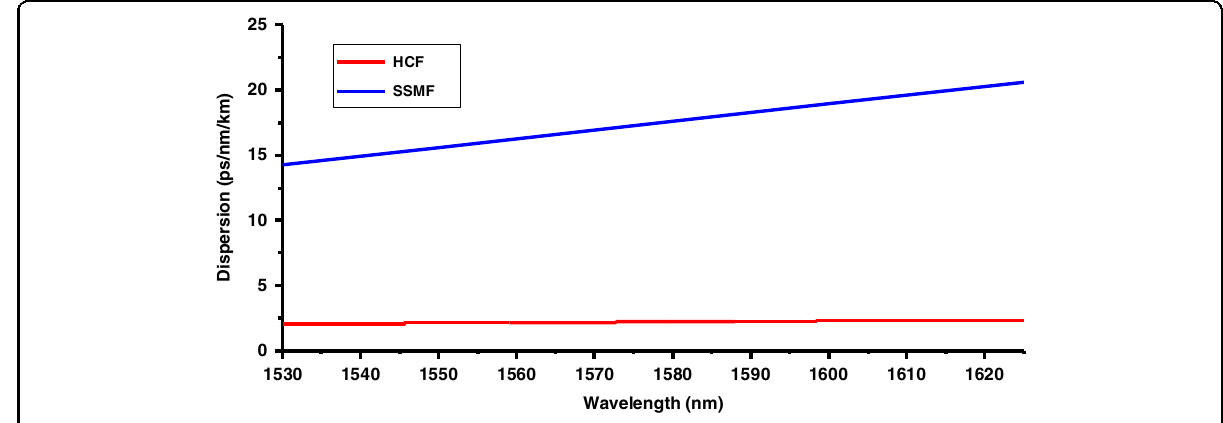
Fig. 15 Measured chromatic dispersion results for 7.7 km HCF (red) and 7.4 km (blue)